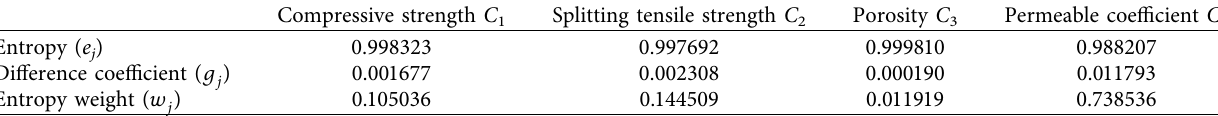
Table 9: Entropy weight calculation results of diferent basalt fber